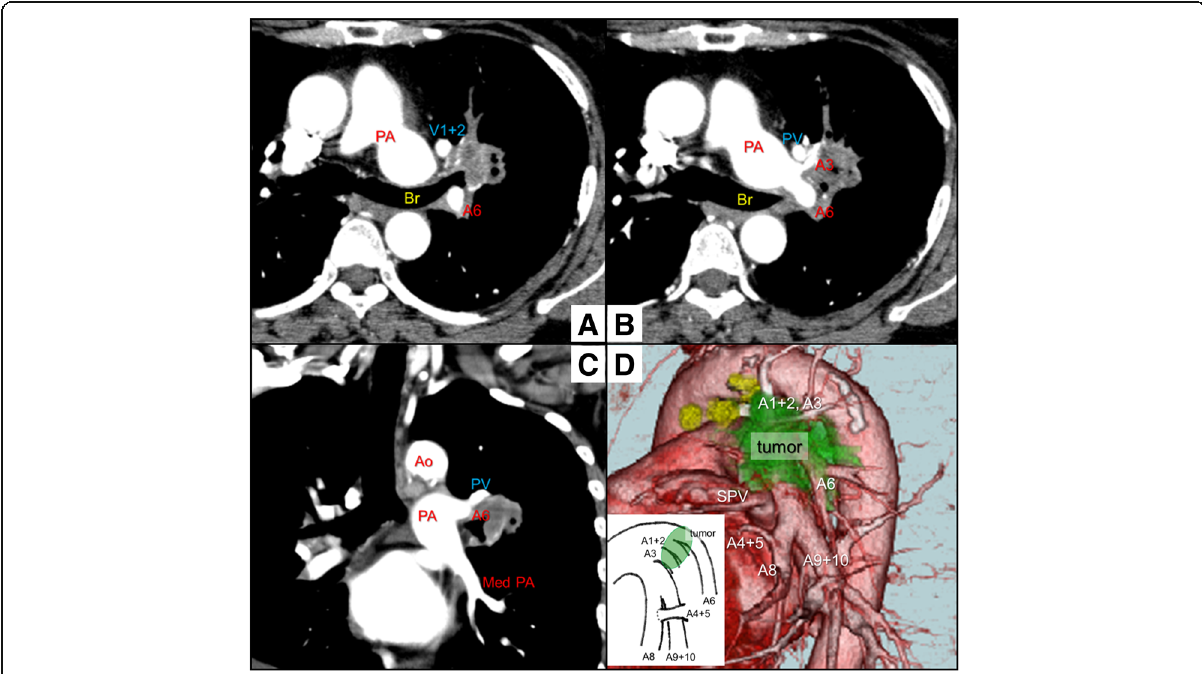
Fig. 1 Chest computed tomography (CT) ( a , b axial view and c coronal view) demonstrated the tumor invading the left upper bronchus in the left upper lung lobe, and the A3 and A6 branches were involved in the tumor. d Three-dimensional CT revealed that pulmonary artery branches (A4 + 5, A8, and A9 + 10) extended into the dorsal side of the superior pulmonary